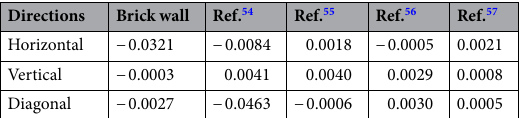
Table 11. Comparative analysis of adjacent pixel